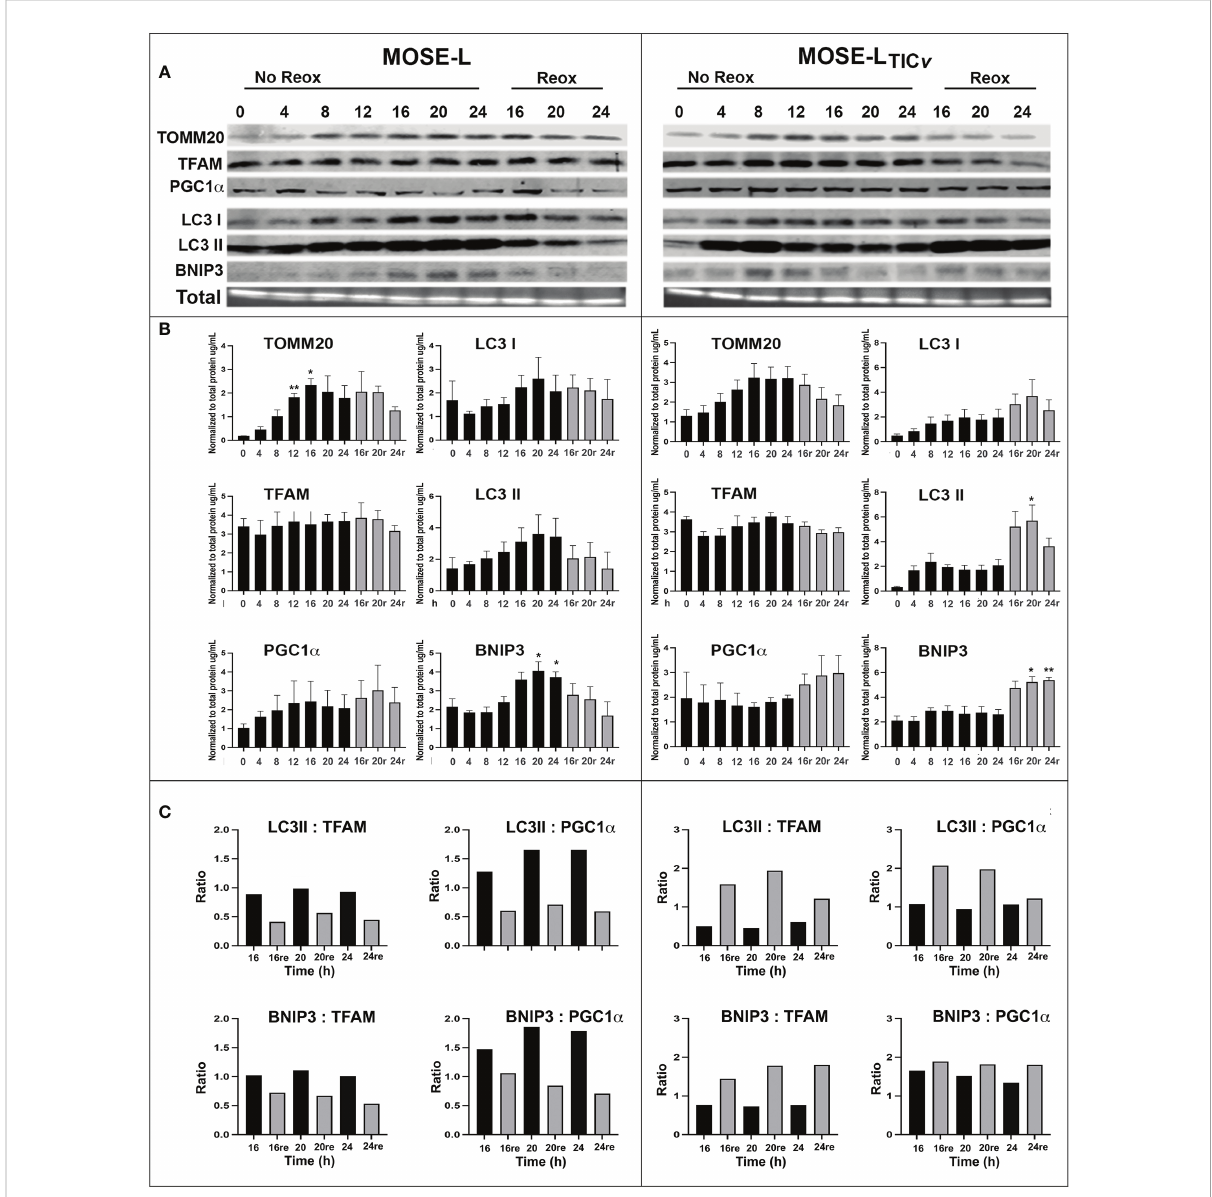
FIGURE 2 Mitochondrial quality control proteins are altered during reoxygenation. (A, B) Western blot for MOSE-L and MOSE-L TIC v spheroids adherent for 0-24 h in non-reox vs. reox (16-24 h) conditions. (C) Ratios of mitophagy: mitobiogenesis proteins comparing reox vs. non-reox spheroids. *p<0.05 vs. control